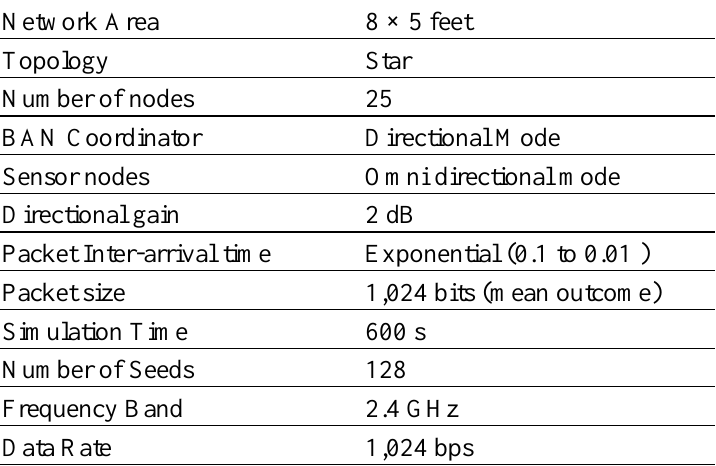
Table 4. Simulation